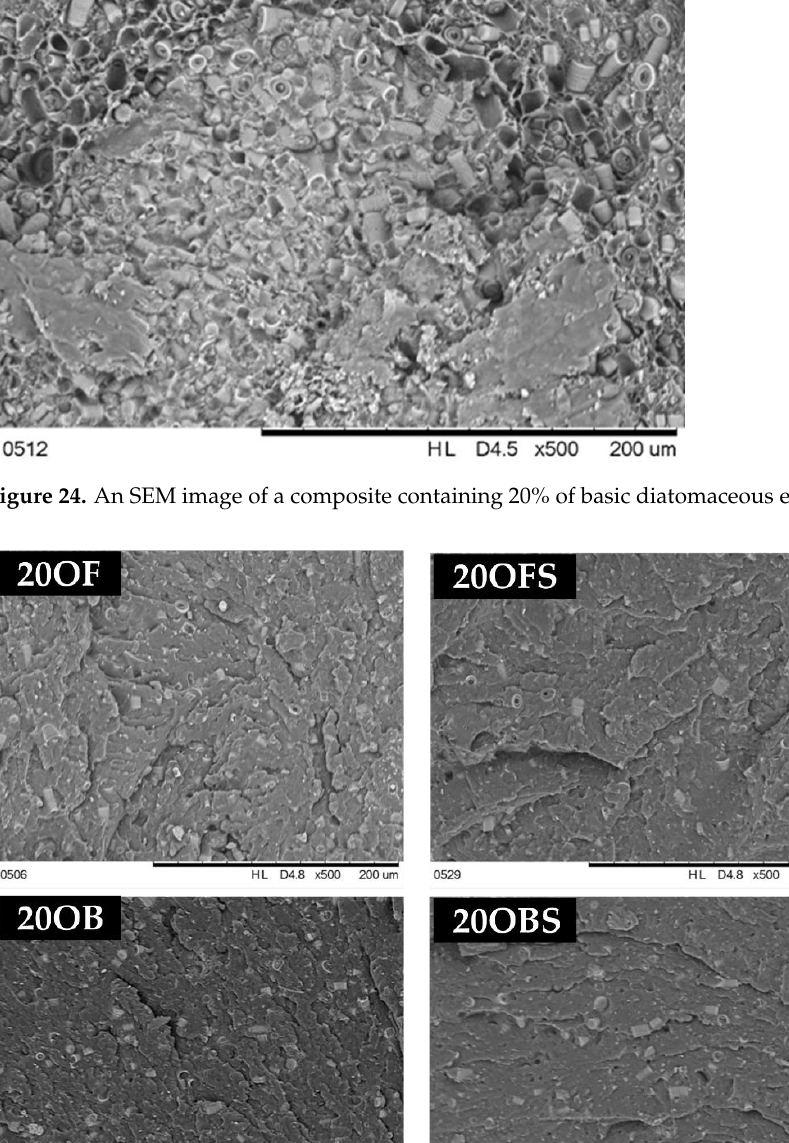
Figure 25. SEM images of composites containing 20% silanized and non-silanized diatomaceous earth.